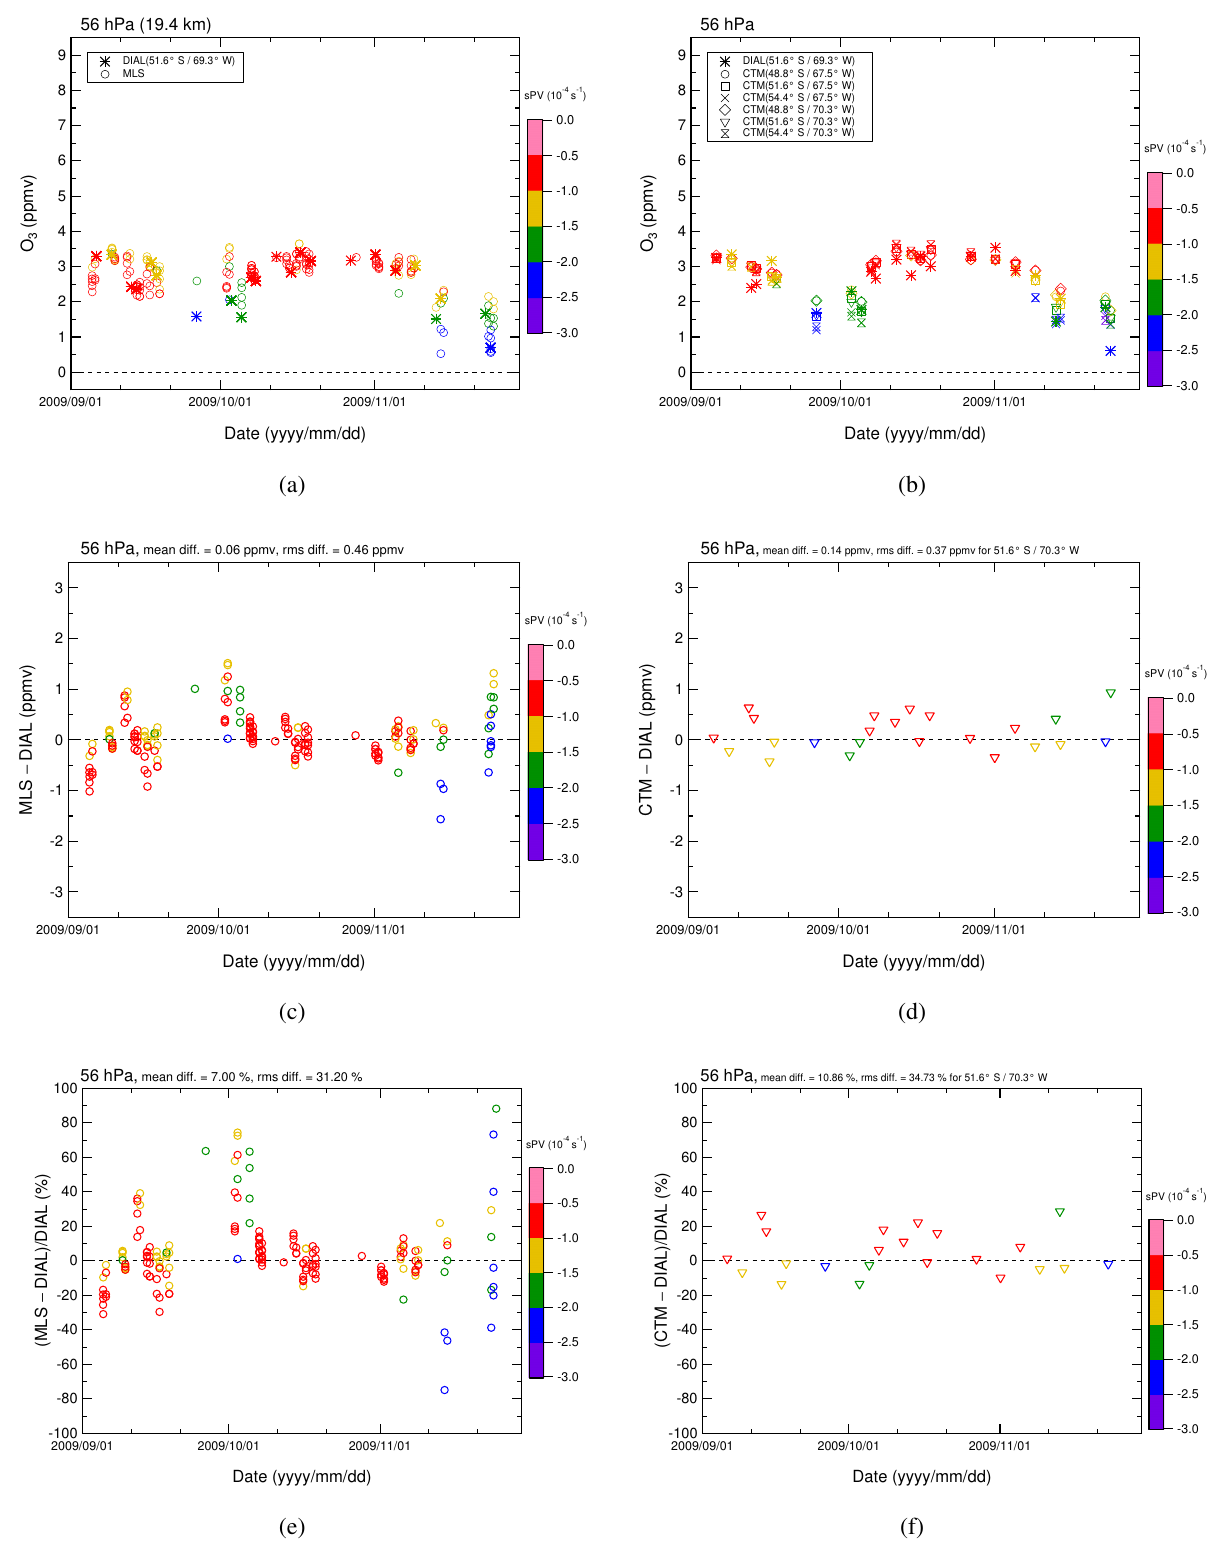
Figure 6. Time series of O 3 mixing ratios as measured by DIAL and MLS at 56hPa (a) and absolute and relative differences between the two (c, e) from September to November 2009, over the OAPA site. Panels (b) and (d, f) are the same as panels (a) and (c, e) , but for DIAL and MIROC-CTM. Data are color coded based on sPV values. For the absolute and relative differences, sPV values for MLS and MIROC-CTM are color coded. For MIROC-CTM, outputs from six grids are shown (see text for additional